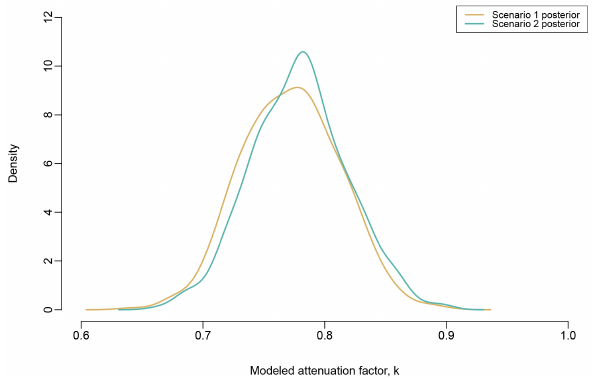
Figure 2. Posterior probability density for the non-GWPA attenua- tion factor, k , for scenario 1 (tan) and 2 (teal).